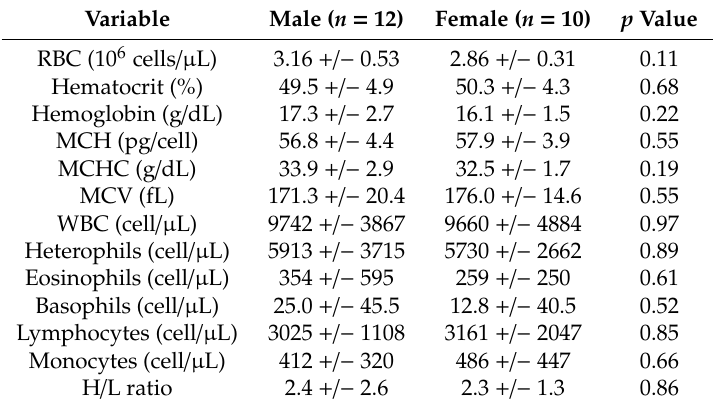
Table 5. Mean ± standard deviation of hematological variables of captive black-faced ibis ( Theristicus melanopis ) according to sex (N = 22).